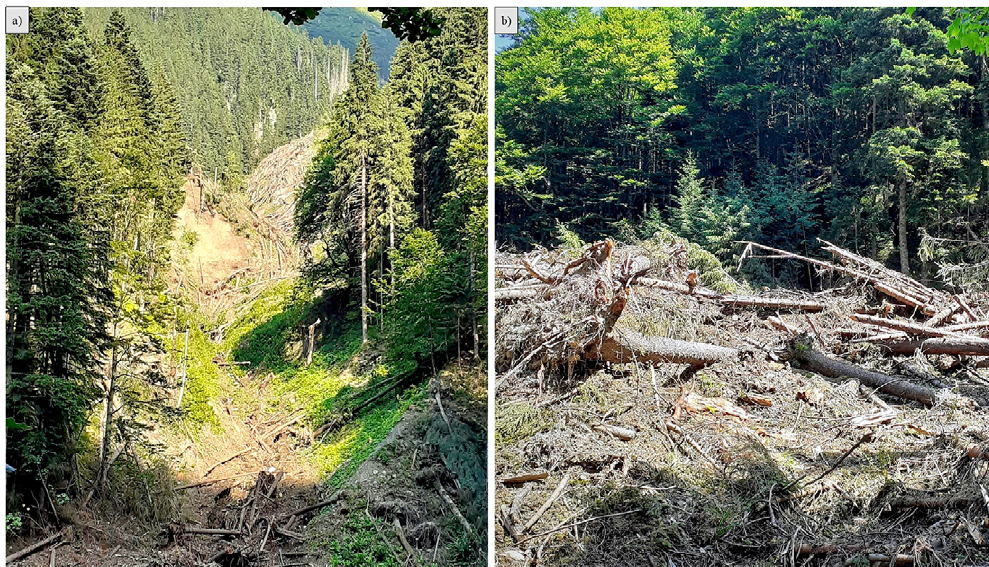
Figure 12. Effects of the major 2021 snow avalanche event on the eastern slope of the Sâmbăta Valley: clear signs of avalanche destruction along the newly created path (a) and the several meters thick wood and debris deposit located in the run-out zone at the confluence with the Sâmbăta Valley